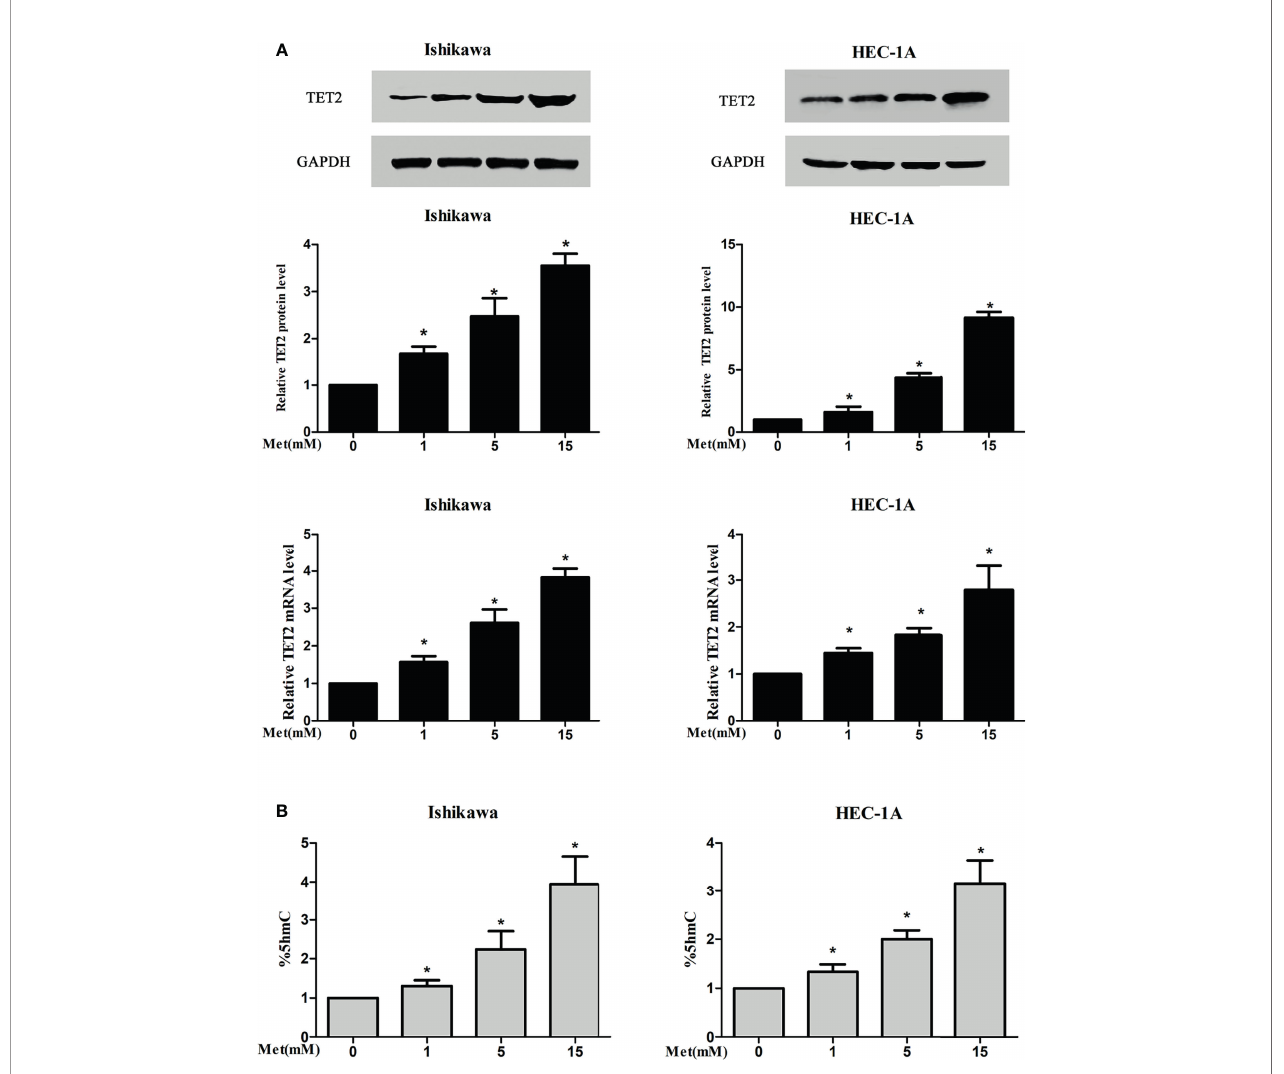
FIGURE 5 | Metformin increased the expression of TET2 and 5hmC in EC cells. Two types of EC cells were treated with metformin at different concentrations for 24 h The expression of TET2 was detected by western blotting and real-time PCR and 5hmC was detected by ELISA. Metformin increased the protein and mRNA expression of TET2 in a dose-dependent manner (A) . Metformin also increased the level of 5hmC in a dose-dependent manner (B) . *P < 0.05, compared with